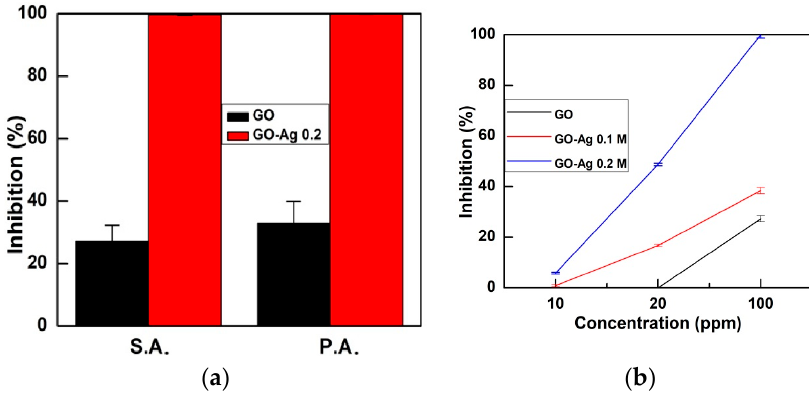
Figure 9. ( a ) The inhibition percentage of P.A. and S.A. bacteria treated with GO and GO-Ag 0.2 M samples at a concentration of 100 ppm; and ( b ) the antibacterial inhibition percentage of GO, GO-Ag 0.1, and GO-Ag 0.2 composites as a function of the load concentration against S.A. bacteria.